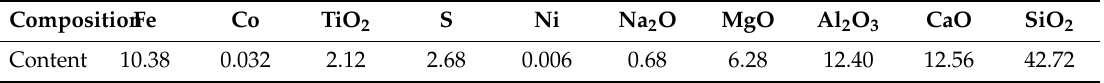
Table 1. Main chemical composition analysis of cobalt containing V–Ti magnetite tailings (%).